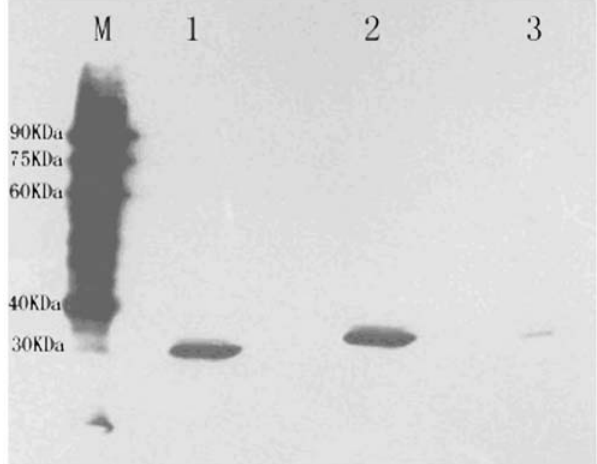
Figure 4. Detection of soluble scFvs in periplasmatic extracts by Western Blot. M: low molecular weight protein marker, lanes1–3: Periplasmatic extracts of scFvs SAS14, SAS68, and SAS71.